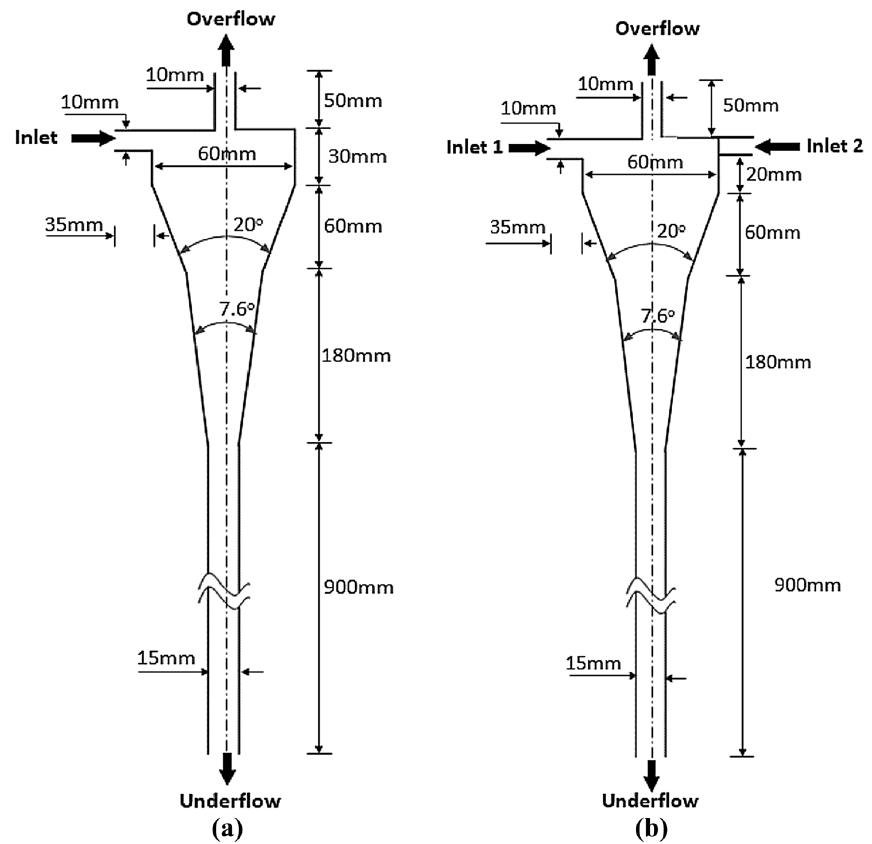
Fig. 3 LLHC geometry: a single inlet; b double inlet